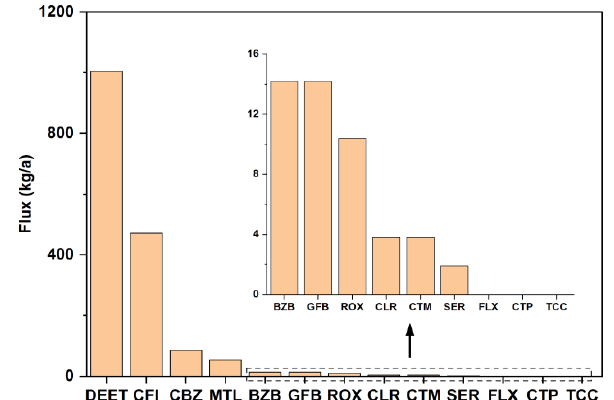
Figure 5. The mean annual fluxes of 13 PPCPs from the inflow rivers in the northern TLB to Taihu Lake in 2021. The water discharge date of the inflow rivers was obtained from the government hydrologic website (http://www.tba.gov.cn/slbthlyglj/sj/sj.html, accessed on 4 July 2022).